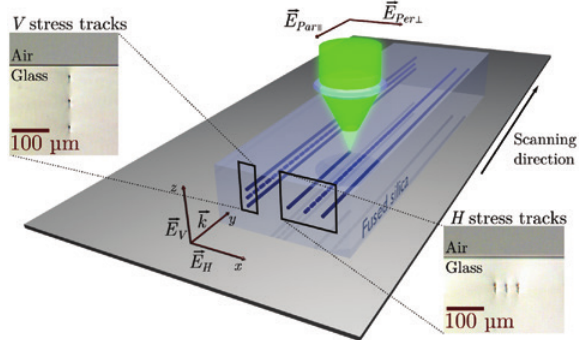
(cid:31) (cid:31) E and E indicate the V H